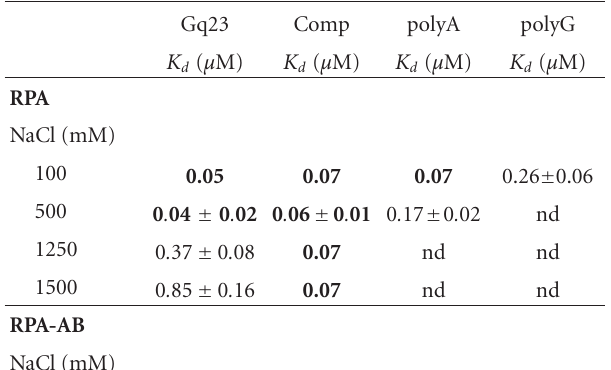
Table 1: Summary of dissociation constants obtained from FP binding assays a,b